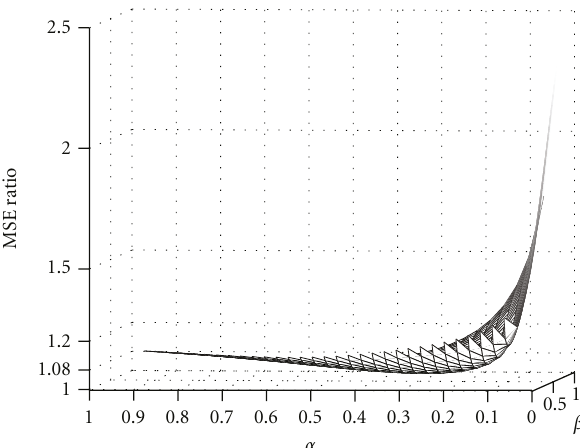
Figure 2: Ratio between MSE of the MSE optimal kernel for the family of locally stationary processes { x Q ( t ) } and the MSE for the kernel optimized for every ( α , β ) ∈ Q .